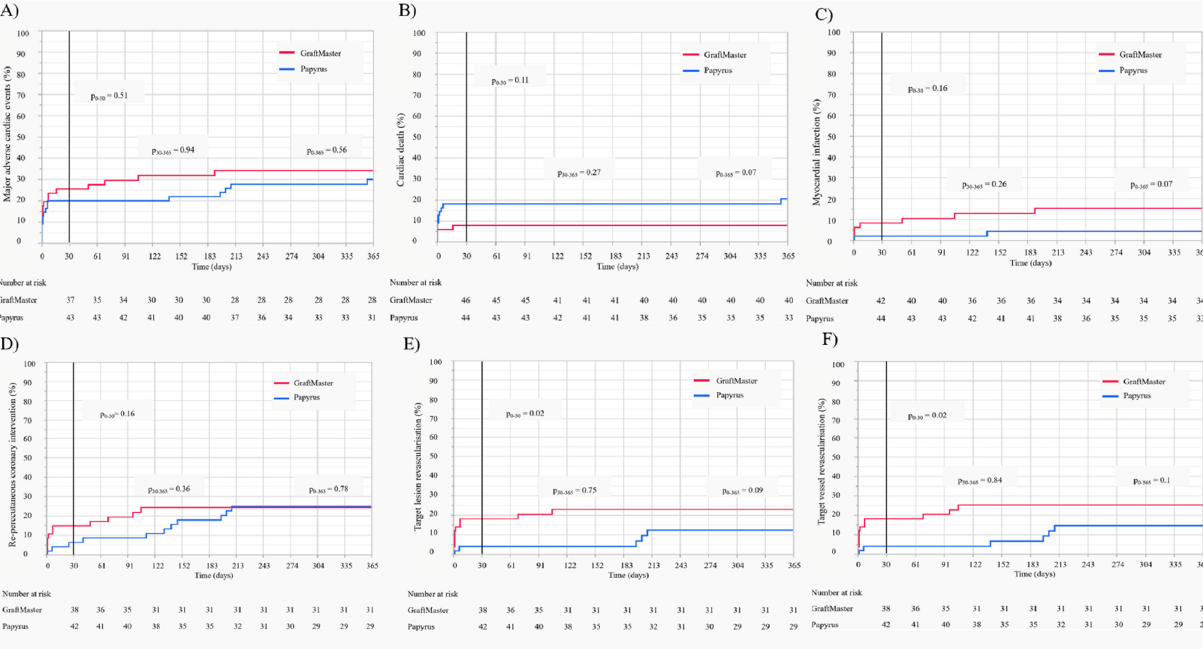
Figure 1. Kaplan–Meier estimates with the follow-up at 30 days and 1 year. ( A ) Major adverse cardiac events (MACE); ( B ) cardiac death; ( C ) myocardial infarction; ( D ) recurrent percutaneous coronary intervention (re-PCI); ( E ) target vessel revascularisation (TVR); ( F ) target lesion revascularisation (TLR).